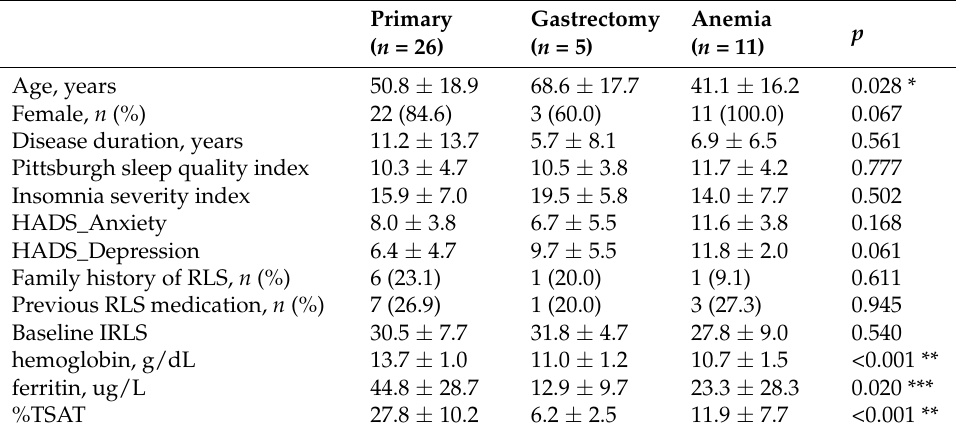
Figure 1. Study flow. FCM, ferric carboxymaltose; RLS, restless legs syndrome. Table 1. Baseline characteristics of primary and secondary RLS